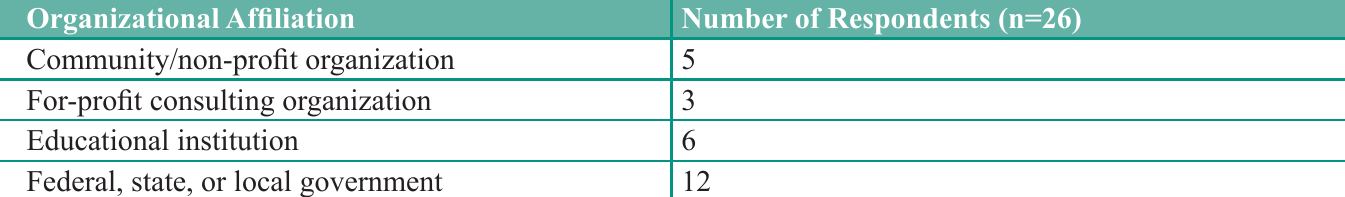
Table 1: Survey respondent